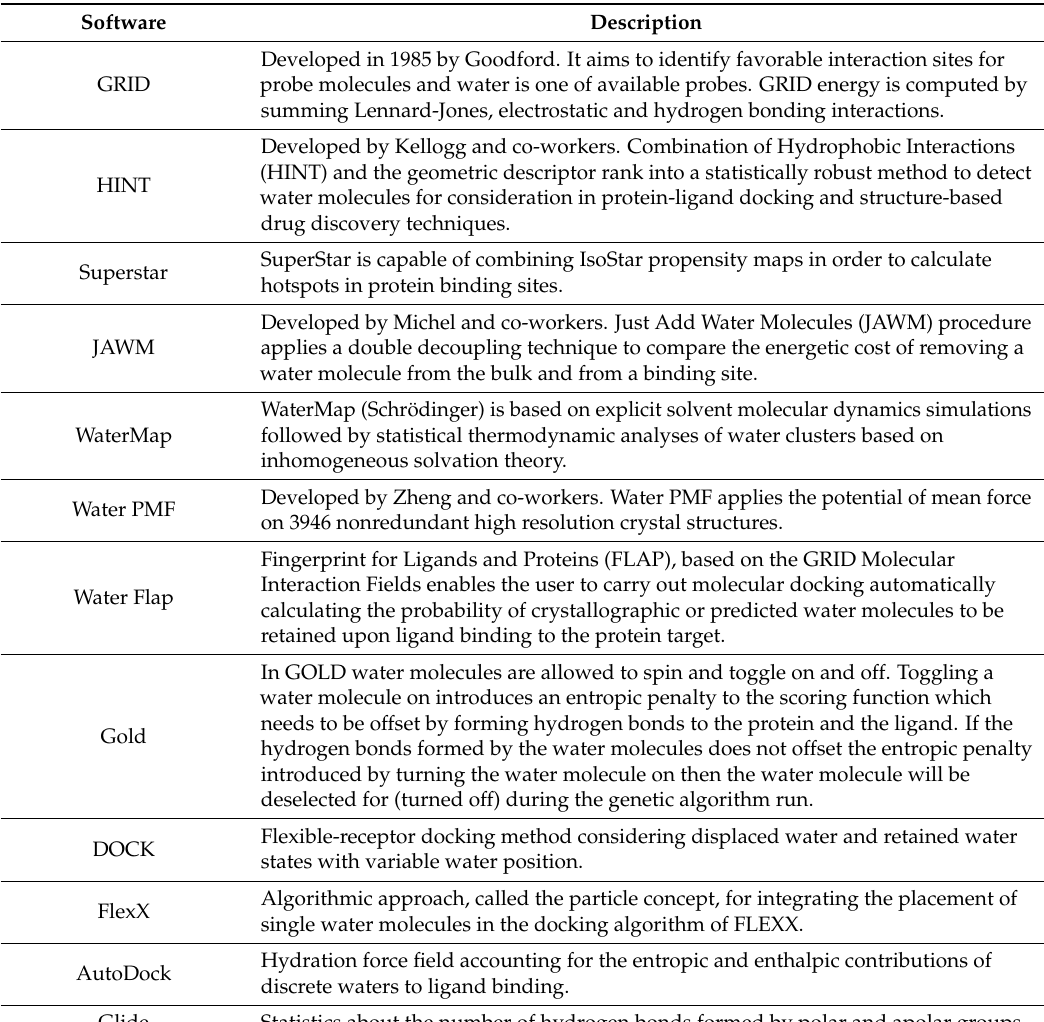
Table 1. Brief summary of the capabilities of available software for predicting water displacement and energetic contributions in docking and